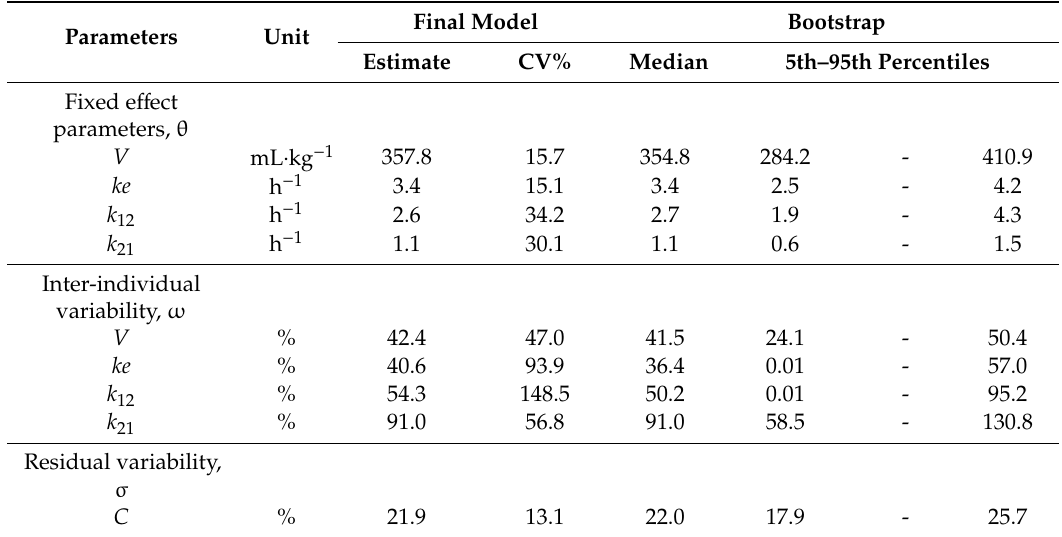
Table 1. PK parameters of L-OHP in rats after administration of 3, 5, or 8 mg / kg L-OHP.